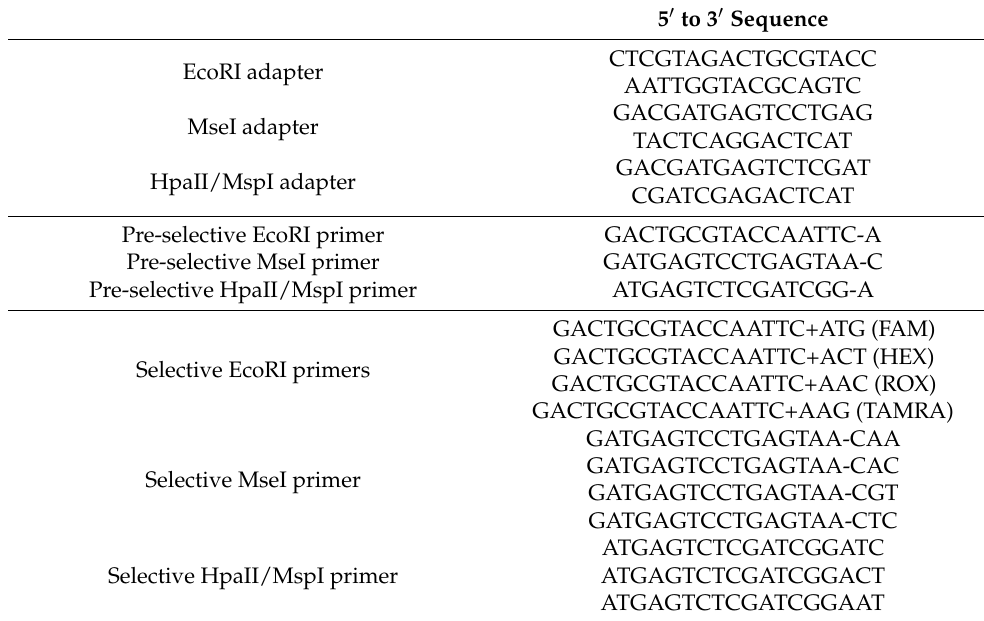
Table 2. Adapters and primers used for the amplified fragment length polymorphism (AFLP) and methylation-sensitive amplified polymorphism (MSAP)